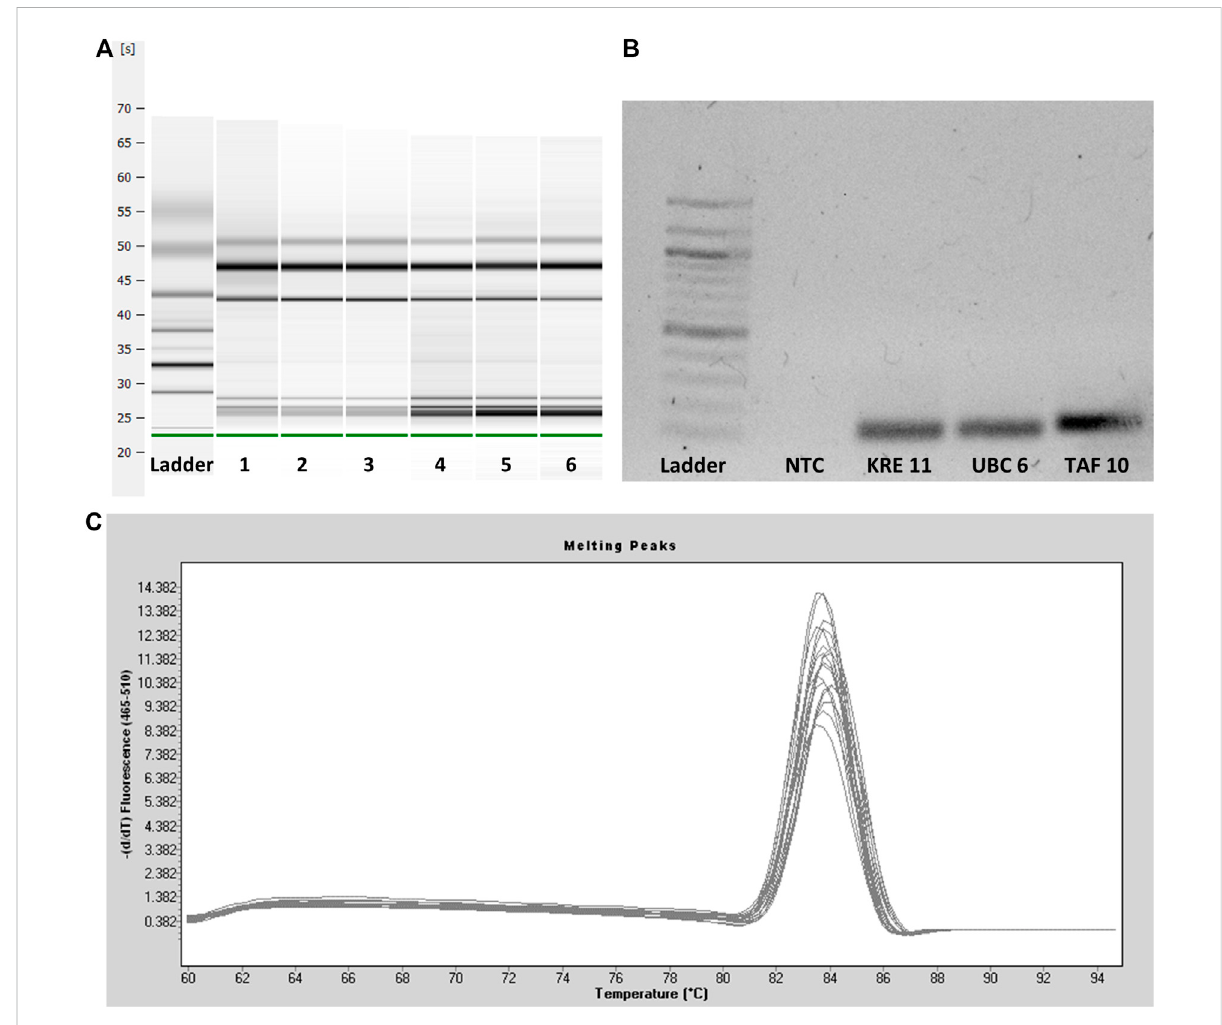
FIGURE 2 (A) CapillarygelelectrophoresisofsixrepresentativeRNAsamples.Theleftmostsampleshowstheladder.Twodistinctbands(28Sand18SRNA) indicate intact RNA samples and good RNA quality after extraction. (B) Agarose gel electrophoresis of three representative primers and one no- template control with a 100 bp ladder leftmost. One single DNA band indicates speci fi cprimer bonding and thesuitability of theprimers. (C) Melting curve analysis of the PCR